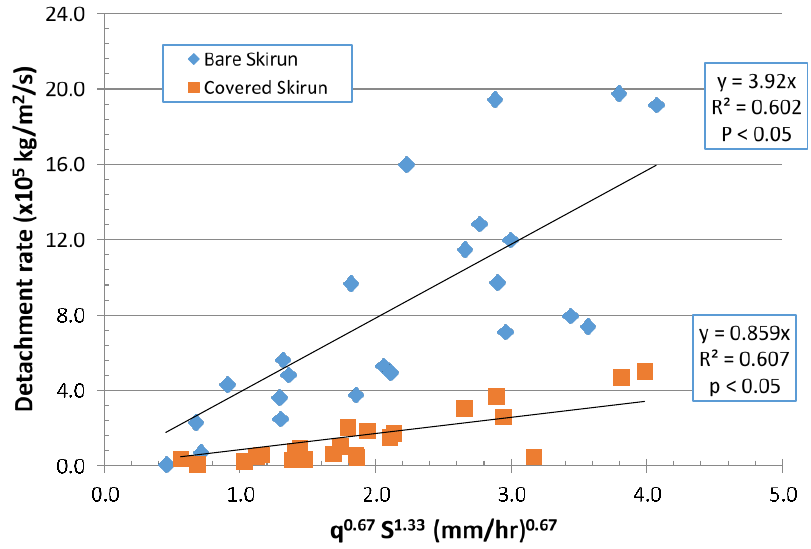
Figure 7. Comparison between and stream power variables for bare and grass-covered volcanic RS plots on the northwest shore of Lake Tahoe.